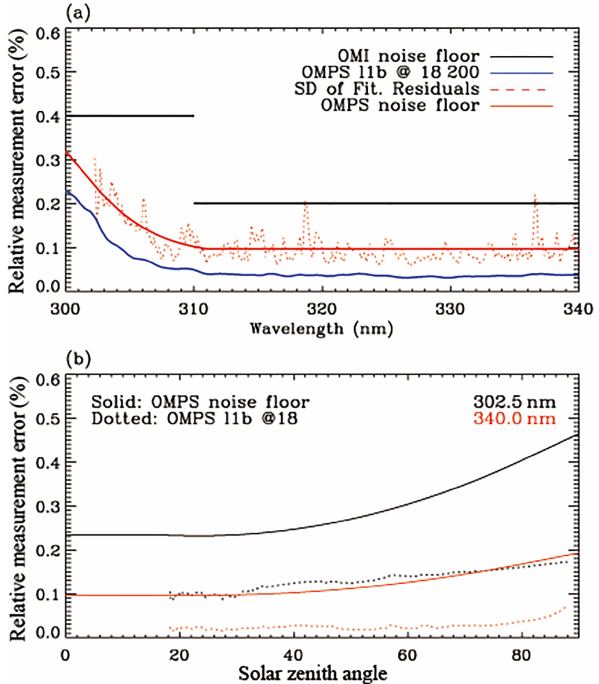
Figure 12. (a) Standard deviations of spectral fitting residuals for 14 March 2013 under clear-sky conditions and for small SZAs <40 ◦ (red dotted line), with the fourth-order polynomial fitting (red solid line) called “OMPS noise floor (NF) error”. This NF error repre- sents the minimum measurement constraint implemented in OMPS ozone fitting process. OMI floor noise error (black line) and OMPS L1B v2.0 random-noise error (blue line; orbit: 7132, cross-track: 18, along-track: 200) are also shown for comparison in the same panel. (b) OMPS NF at 302.5 and 340nm as a function of SZAs (solid line), with the corresponding OMPS L1B v2.0 measurement error (dotted